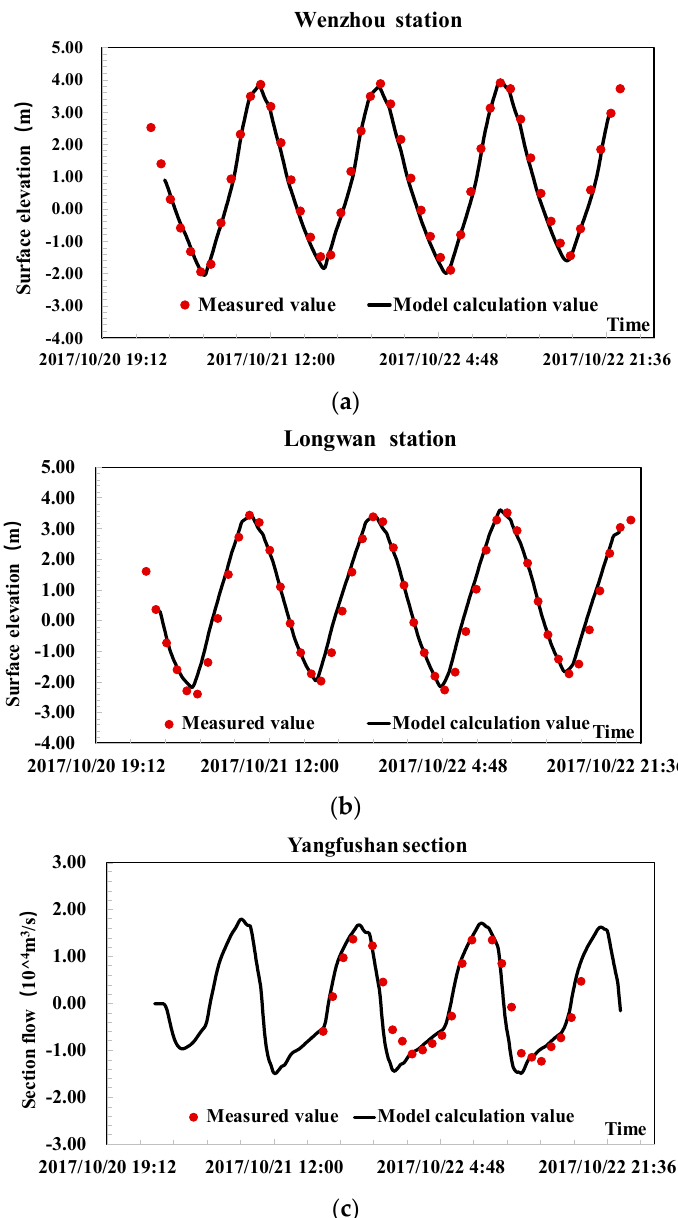
Figure 3. Verification of tidal level and flow process at some stations during hydrometry in October 2017: ( a ) Verification process of Wenzhou Tide Level Station; ( b ) Verification process of Longwan Tide Level Station; ( c ) Verification process of Yangfushan Section flow.